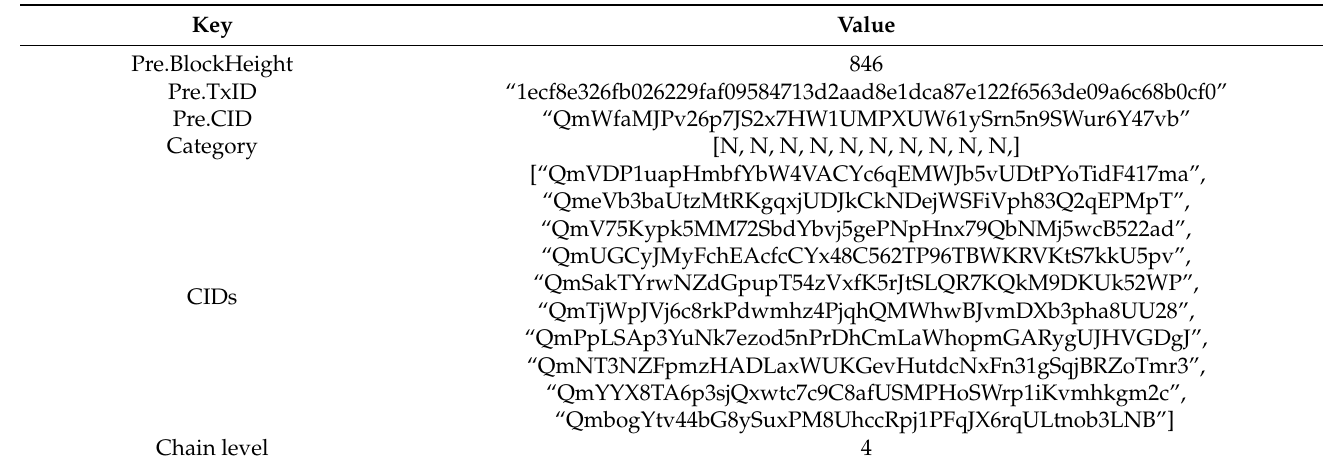
Table 1. An example of a pointer file.